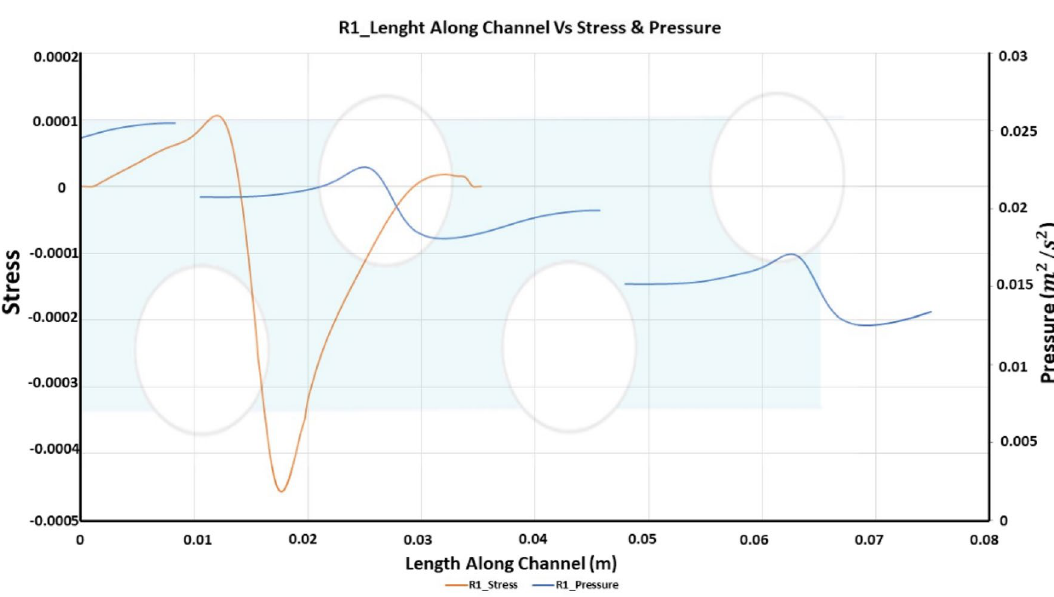
Figure 5. Length along channel vs stress and pressure for